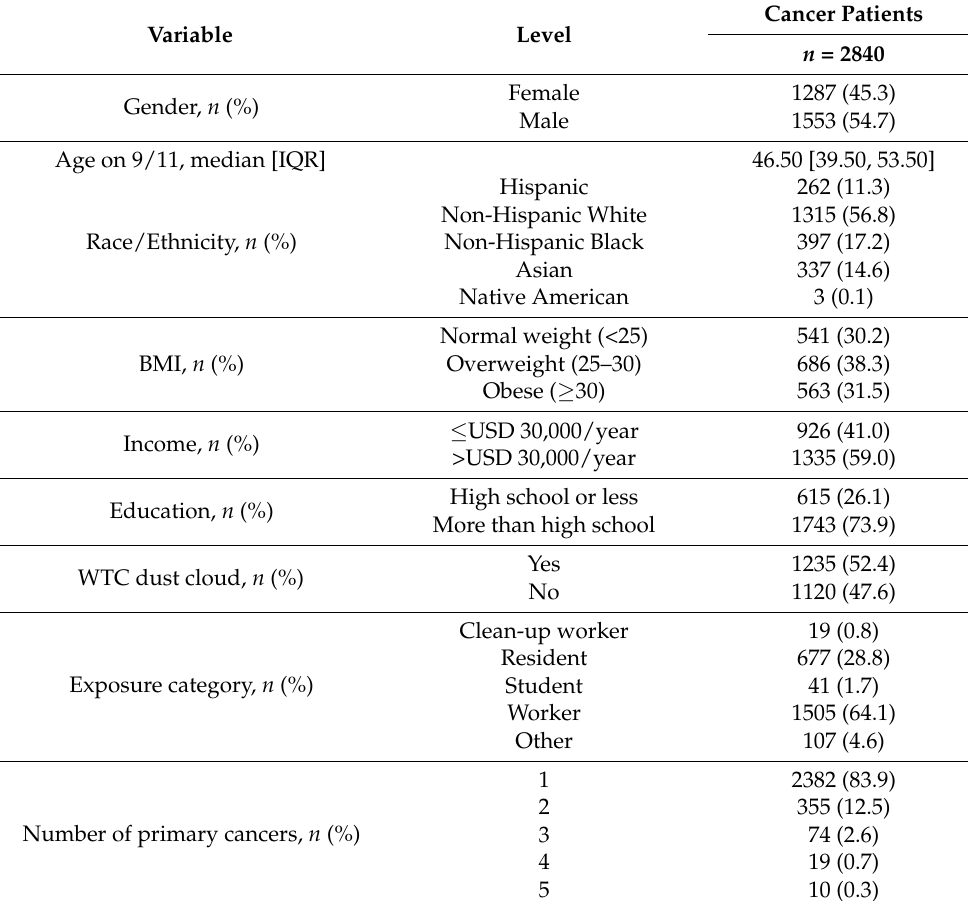
Table 1. Demographic characteristics of cancer patients in the WTC EHC pan-cancer